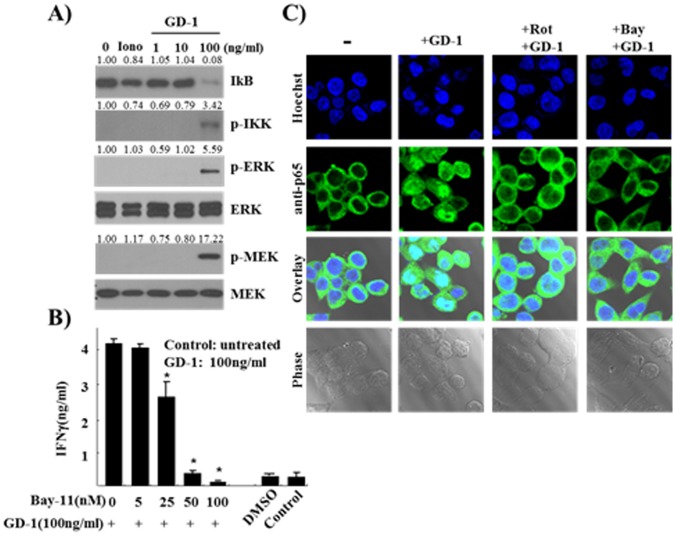
IFN-γ production induced by GD-1 is dependent on NF-κB activity.
A. GD-1 was treated onto NK-92 cells at 1 to 100 ng/ml concentrations, and several down-stream targets for PKC signaling were analyzed by Western blotting. The phosphorylation of IKK was detected with the concomitant degradation of IκB. ERK and MEK were also phosphorylated by GD-1 treatment. The bands were quantified using Quantity One 1-D Analysis Software (Bio-Rad Laboratories) and p-IKK and IκB expression normalized to control their protein expression. And p-ERK and p-MEK expressions normalized to total their protein expression. The values are given above the blots. B. Inhibitors of NF-κB, Bay11-7082, was treated with a serial dilution from 100 µM with 10 0 ng/ml GD-1, and IFN-γ production was analyzed by ELISA. The addition of Bay11-7082 has showed an inhibitory effect on GD-1 activity to increase IFN-γ production. All ELISA data are representative of at least three independent experiments. Triplicate samples in each time were tested and averaged. Error bars indicate standard deviation. *P<0.05. C. The nuclear translocation of p65 (an NF-κB subunit) was observed in GD-1-stimulated NK-92 cells. The modulation of cytoskeleton was observed through Phase contrast images and DAPI was used to visualize nuclei. GD-1 treatment onto NK-92 cells induced nuclear localization of cytosolic p65 transcription factor, which was inhibited by the co-addition of Rottlerin or Bay11-7082.